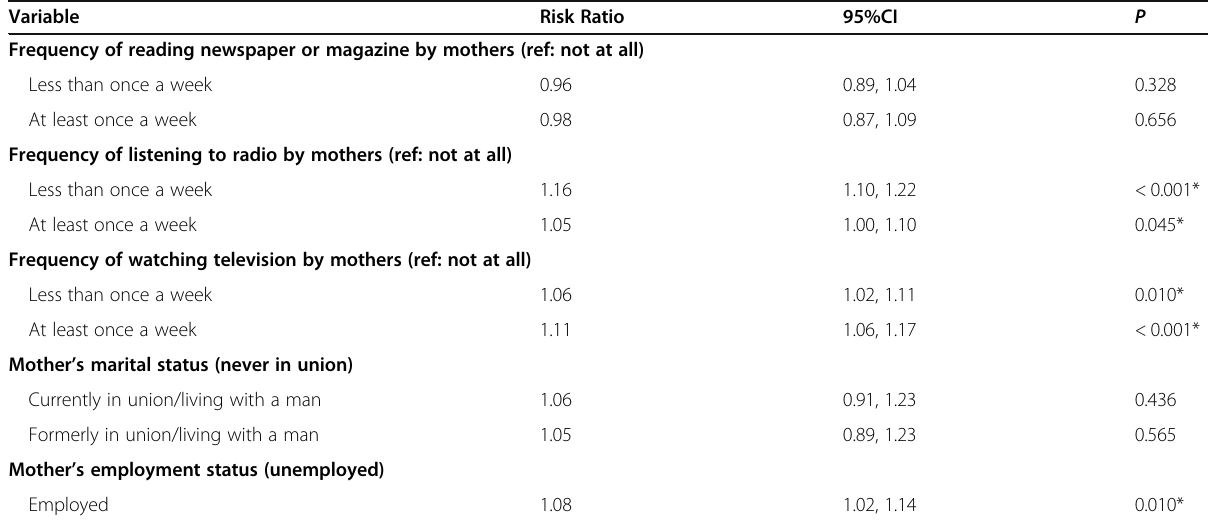
Table 2 Multivariable log binomial model of the factors associated with optimal cognitive development (Continued)